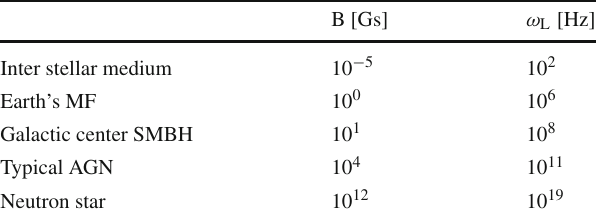
Table 5 Magnitudes of some relevant astrophysical MFs and their related Larmor